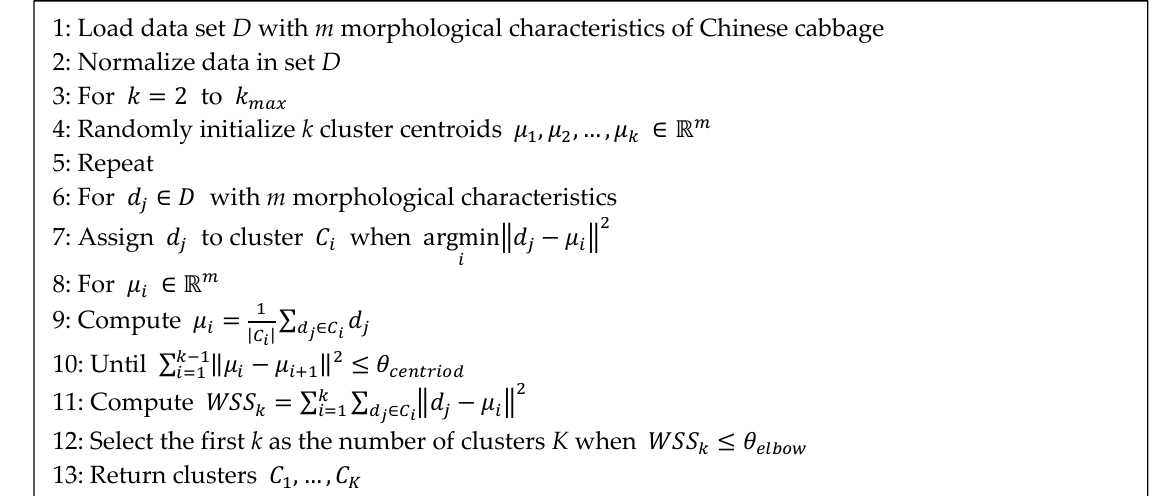
Figure 2. Pseudo code of the k -means clustering for Chinese cabbage segmentation.